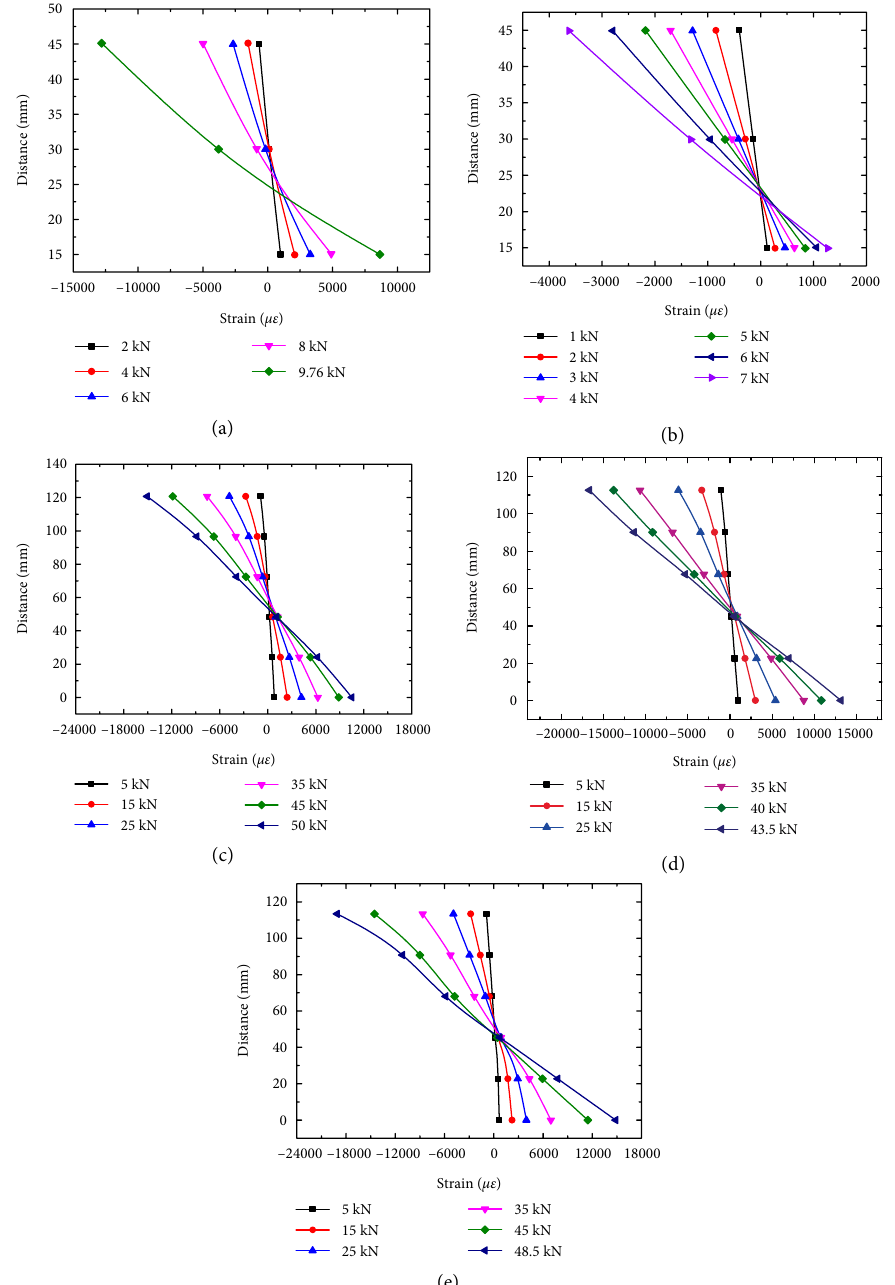
Figure 11: Strain distributions along beam height under different loads: (a) A0, (b) A1, (c) B0, (d) B1, and (e)